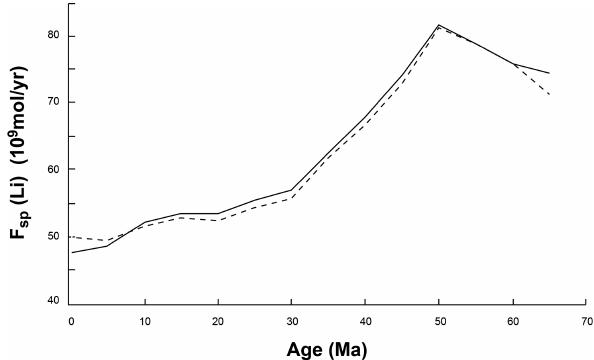
Figure 4. Flux of lithium incorporated into continental secondary phases as a function of time ( F sp ), see Eq. (6), following solution no. 2 of the modeling (shown in Fig. 3b). Comparison is made using a linear evolution for river δ 7 Li as a function of time, from 15 (at 65Ma) to 23‰ (present day) (dashed